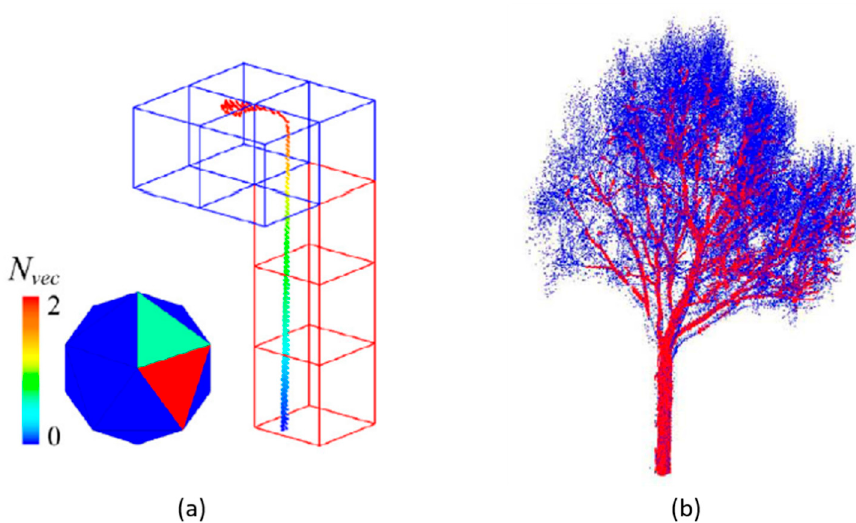
Figure 6. Pole-like objects and roadside trees. ( a ) Wang et al. [114] recognize street objects using a voxel-based shape descriptor determined by the orientation of the significant eigenvectors of the object at several levels of an octree. Nvec represents the number of eigenvectors that intersect each triangle of the 3D descriptor (icosahedron) ( b ) Xu et al. [122] recognize trunks (red) and tree branches (blue) by optimally merging clusters of points.